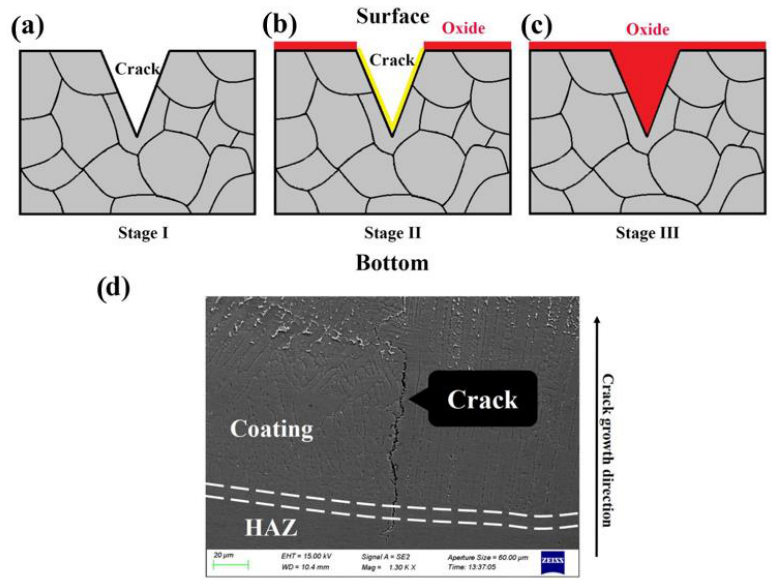
Figure 15. Schematic ( a – c ) and SEM ( d ) of the high-temperature oxidation mechanism of the surface cracks in the IN718 coating.